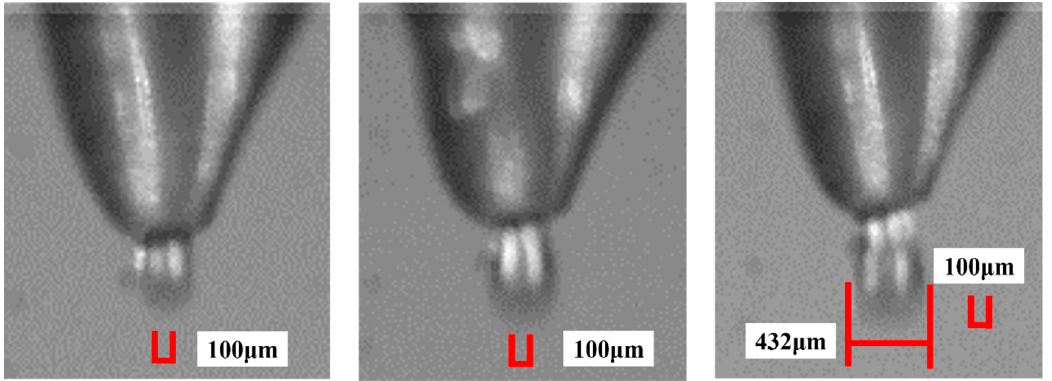
Figure 11. The diameter of droplets at different moments in the second set of experiments.